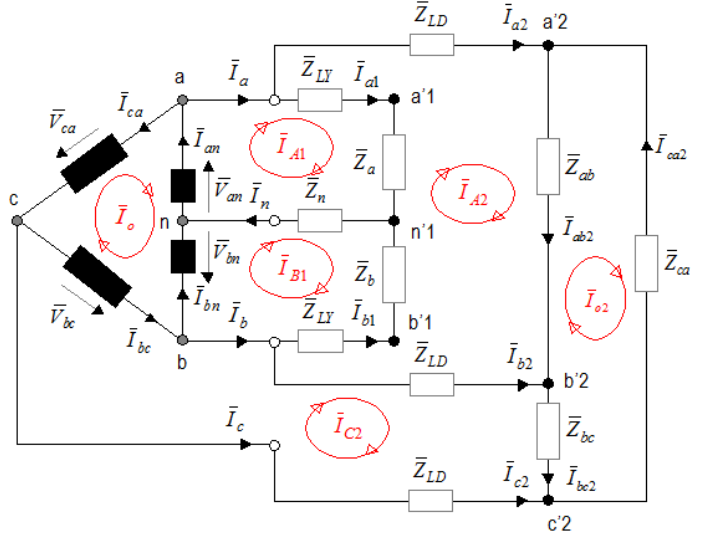
Figure 3. 4WD service: secondary circuit scheme and loop